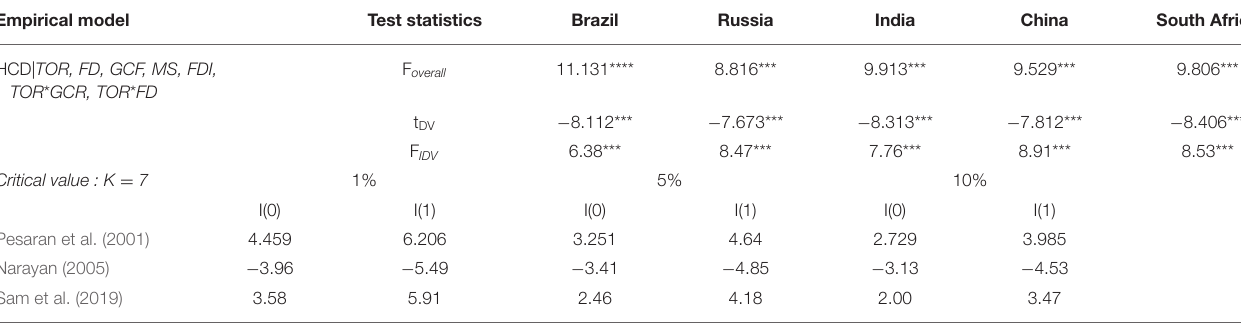
TABLE 8 | AARDL cointegration with the interactive term. Empirical model